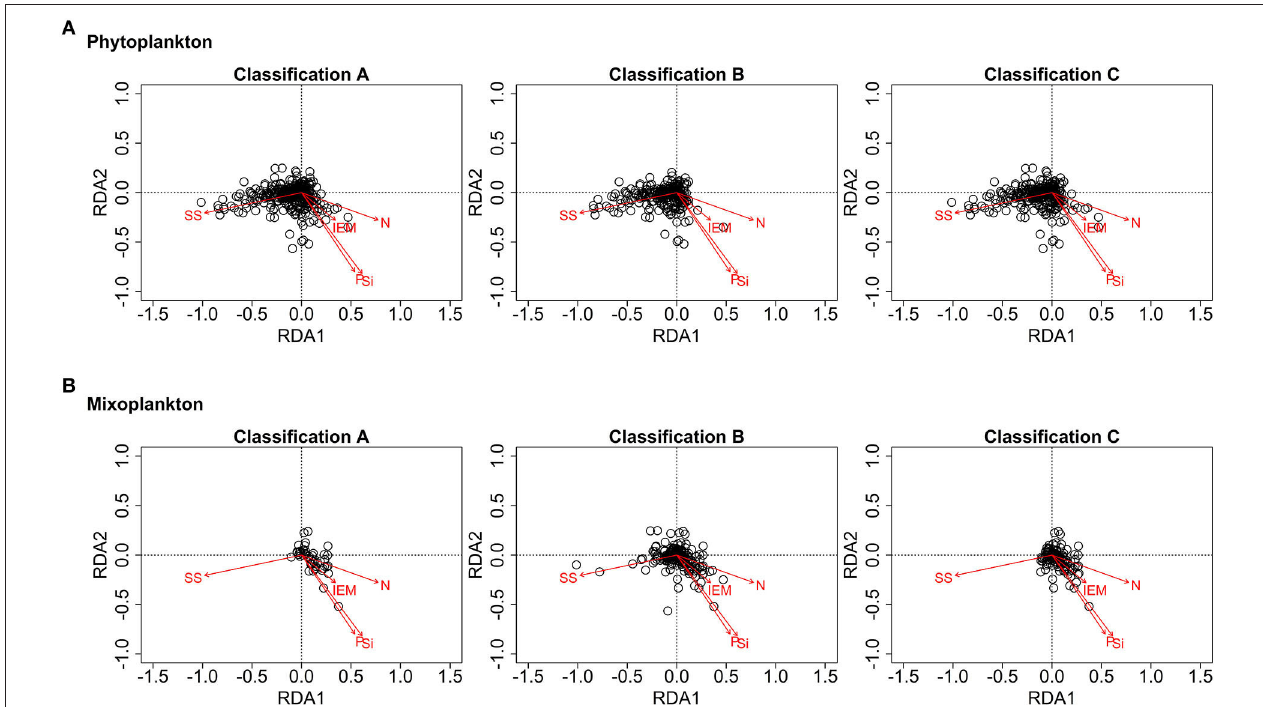
FIGURE 9 | RDA ordination plots for phytoplankton (A) and mixoplankton (B) (SS, suspended sediment; IEM, index of ecosystem maturity; N/P/Si, nitrogen, phosphorus, silica concentration). (A) Phytoplankton are oriented along the suspended sediment gradient. (B) Documented and likely mixoplankton are oriented toward the IEM and nutrient concentration